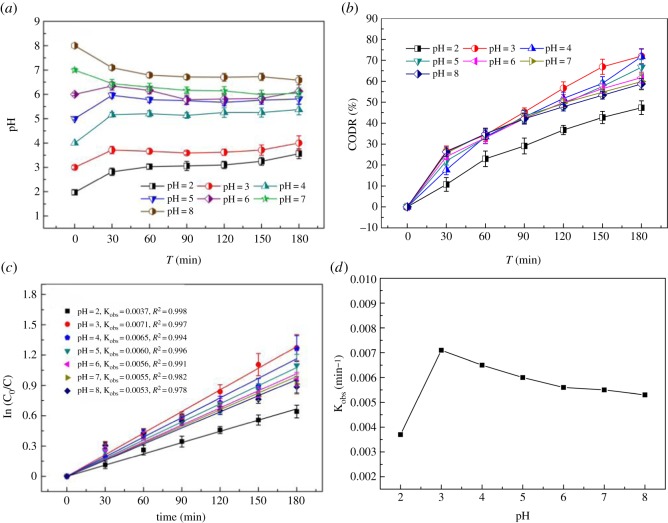
Effect of initial pH on pH variation and COD removal efficiency in the EF process. (a) pH variation in reaction solutions in EF process, (b) COD removal efficiency of ML-GFW, (c) COD removal efficiency described by the first-order equation, (d) Kobs (min−1) for ML-GFW removal efficiency. Conditions: 500 ml ML-GFW; I = 2 A; period reversal time: 10 min; H2O2: 7 ml/30 min; reaction time: 3 h.